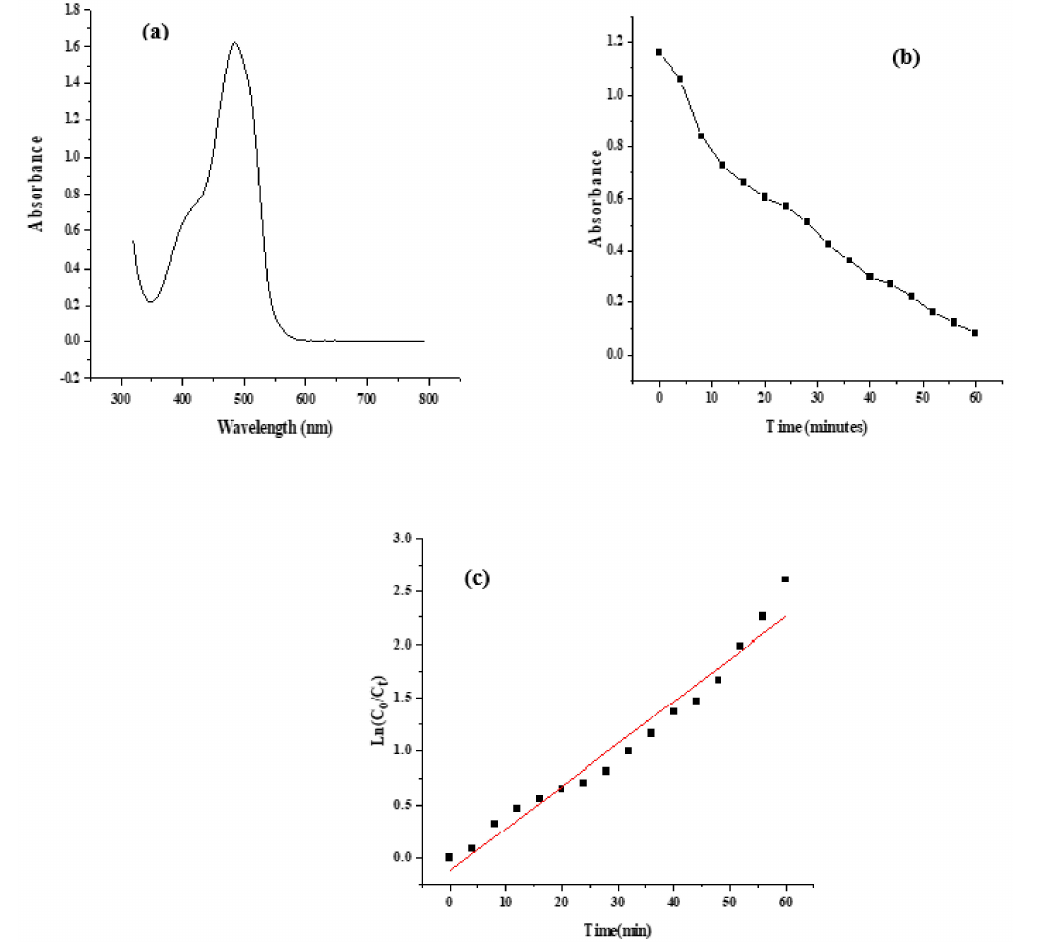
Figure 13. ( a , b ) UV-Vis spectrum of methyl orange solution in water ( a ), degradation trend of methyl orange after addition of catalysts, kinetically plotted graph ( c ).